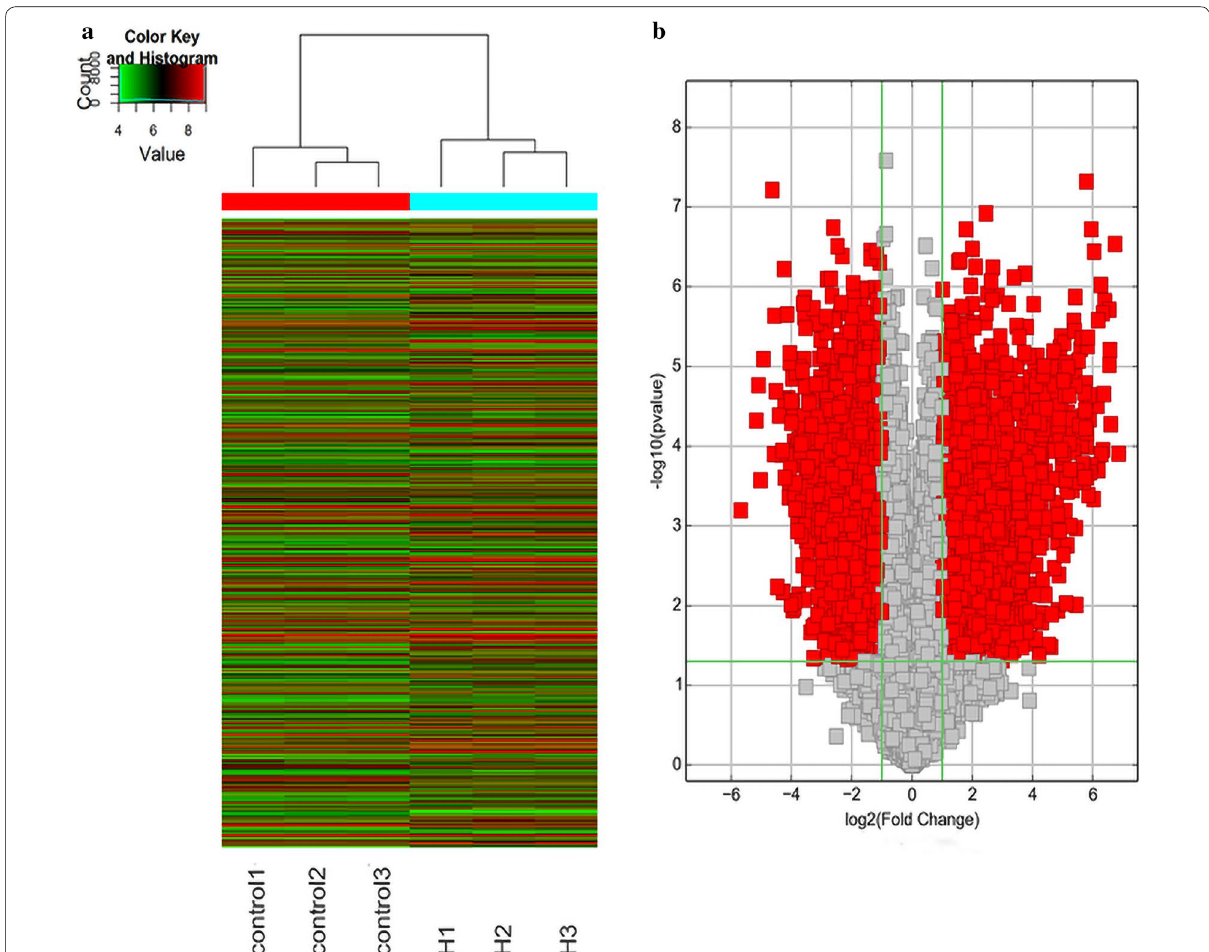
Fig. 2 The heat map of the differentially expressed gene and the volcano plot of visualizing differential expression variation between syphilis combined with diabetes and controls. a The data are depicted as a data matrix, in which red represents high relative expression and green represents low relative expression. b The vertical lines correspond to 2.0-fold up and down, respectively, and the horizontal line represents a p-value of 0.05. Red point in the plot represents the DEGs with statistical